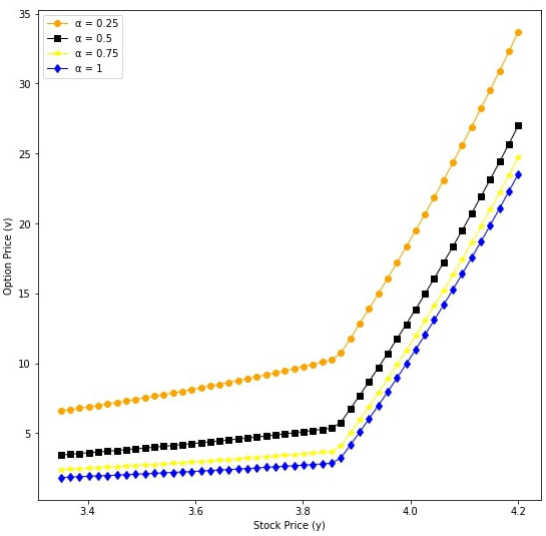
Figure 10. Option prices v ( t , x , y ) with respect to underlying asset y for different α values : v for x = 2.3024 and ρ =